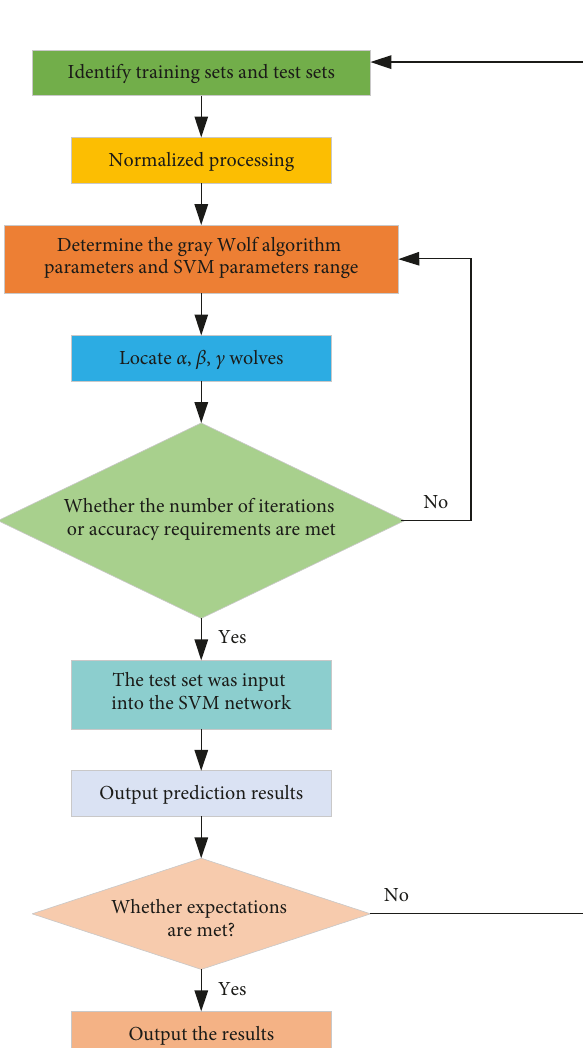
Figure 3: Flowchart of IGWO-SVM prediction